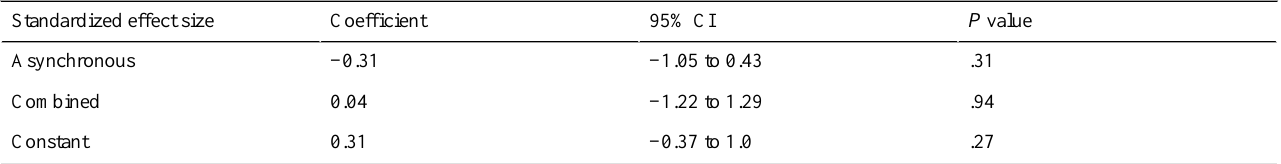
Table 3. Metaregression of synchronous and asynchronous interventions on quality of life outcome, analyzed using standardized effect size.